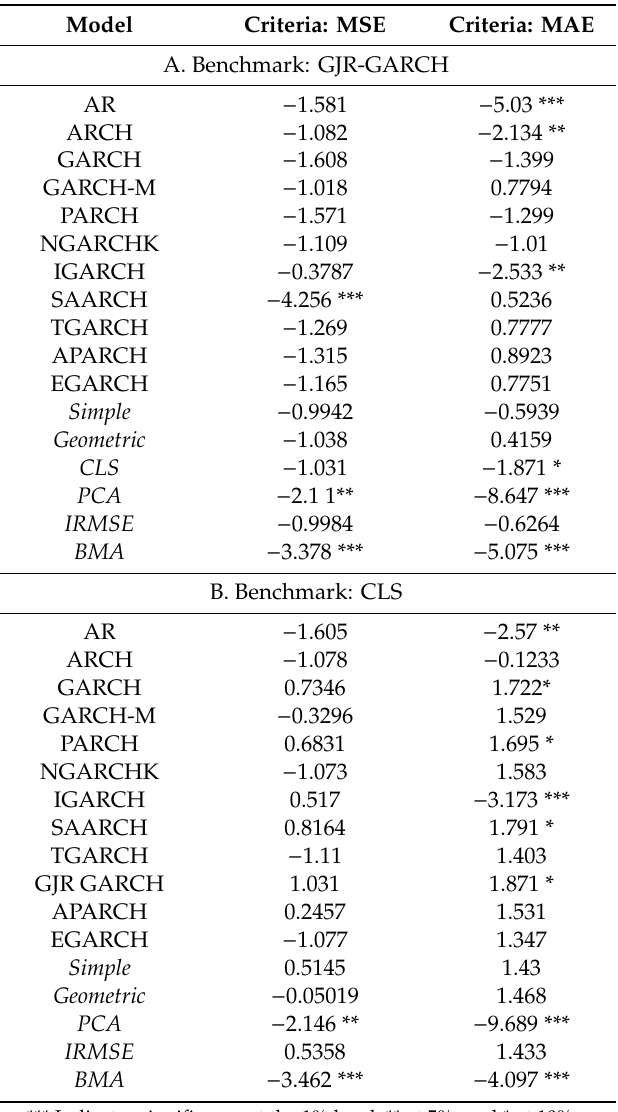
Table A4. Electricity prices: Diebold–Mariano test statistic for forecast accuracy of GJR-GARCH and CLS. MSE and MAE are used as criteria (following Mohammadi and Su, [79]. In panel A, we evaluate the forecast accuracy of the GJR-GARCH compared to that of all other models; while in panel B, we evaluate the CLS combination with all other